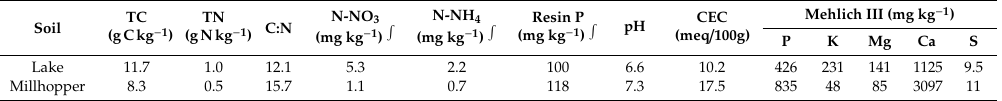
Table 1. Soil properties measured at the start of the study: total carbon (TC), total nitrogen (TN), C:N, nitrate nitrogen (N-NO 3 ), ammonium nitrogen (N-NH 4 ), cation exchange capacity (CEC), phosphorus (P), potassium (K), magnesium (Mg), calcium (Ca), and sulfur (S). All measurements were conducted on one sample, using dry soil except those indicated as fresh soil (